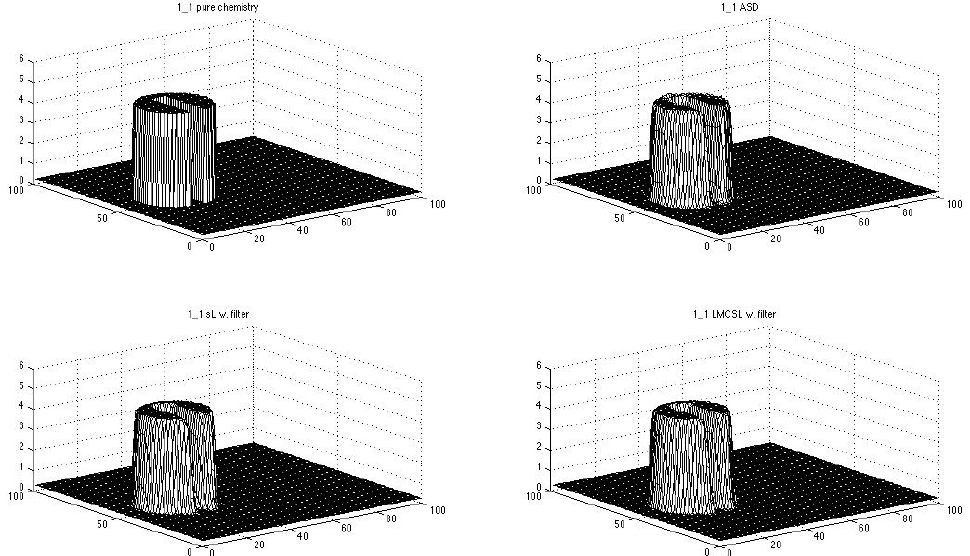
Fig. 11. Slotted cylinder, pure advection, 1t = 90s, 1x = 1 . 0, C = 0 . 327 Rotation test with the slotted cylinder for pure advection and resolution 1 1, with 1t = 90s, 1x = 1 . 0, and C = 0 . 327. The results are given for initial concentration (top left) and pure advection for ASD (top right), semi-Lagrangian interpolation with filter (bottom left), and LMCSL with filter (bottom right). The minimum and maximum values for the respective plots are: Top left: min=0.2406, max=4.811. Top right: min=0.0572, max=5.022. Bottom left: min=0.2406, max=4.811. Bottom right: min=0.2406,